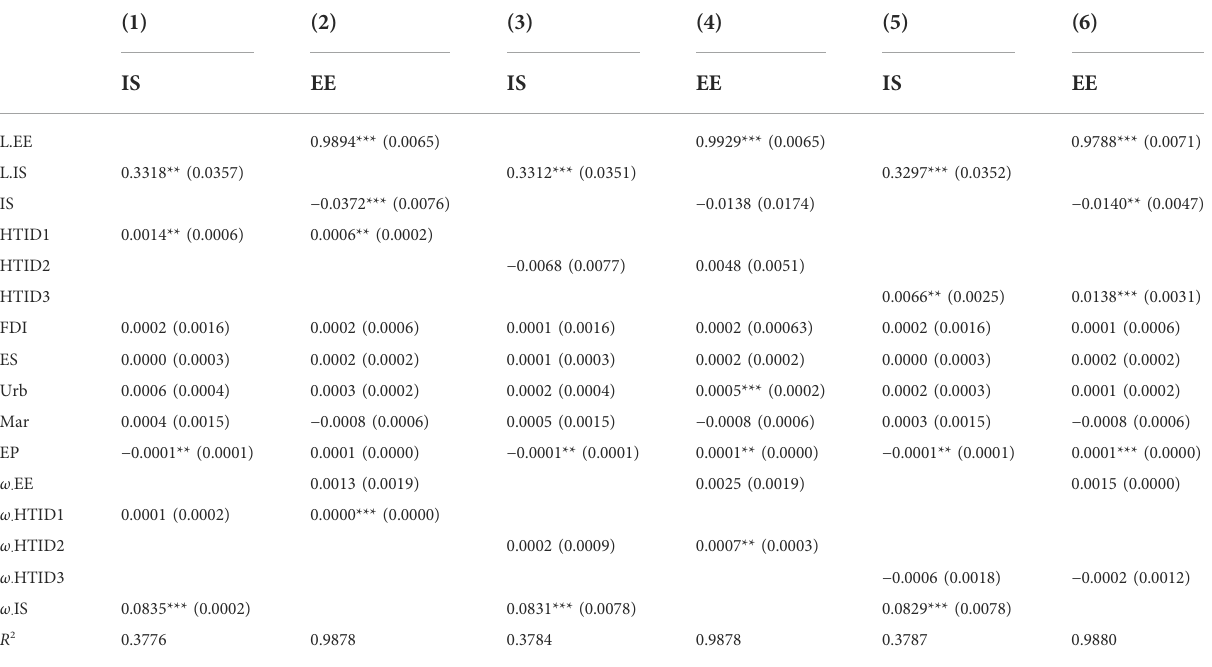
TABLE 8 Intermediate effect test of industrial structure (Theil